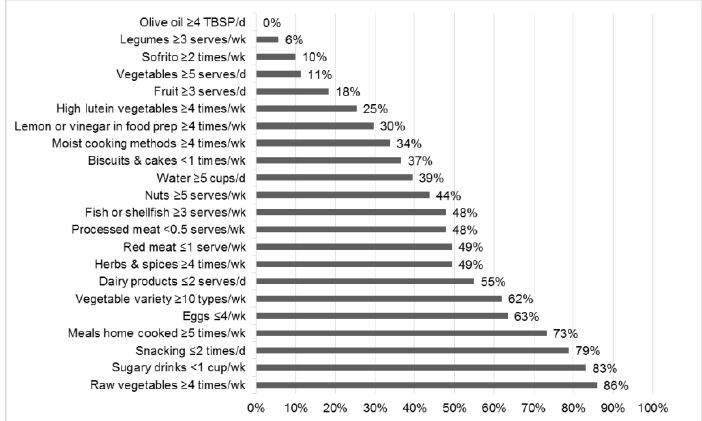
Figure 2. Percent of participants who reached Mediterranean diet thresholds according to three-day food records ( n = 71). Thresholds defined by highest cut-offs used in MediCul tool for the relevant questions [22] . Abbreviations: n , number of participants; d, day; Prep, preparation; Sofrito, a sauce made with tomato, onion/garlic and olive oil, used as a base for savory dishes; TBSP, tablespoon; wk,